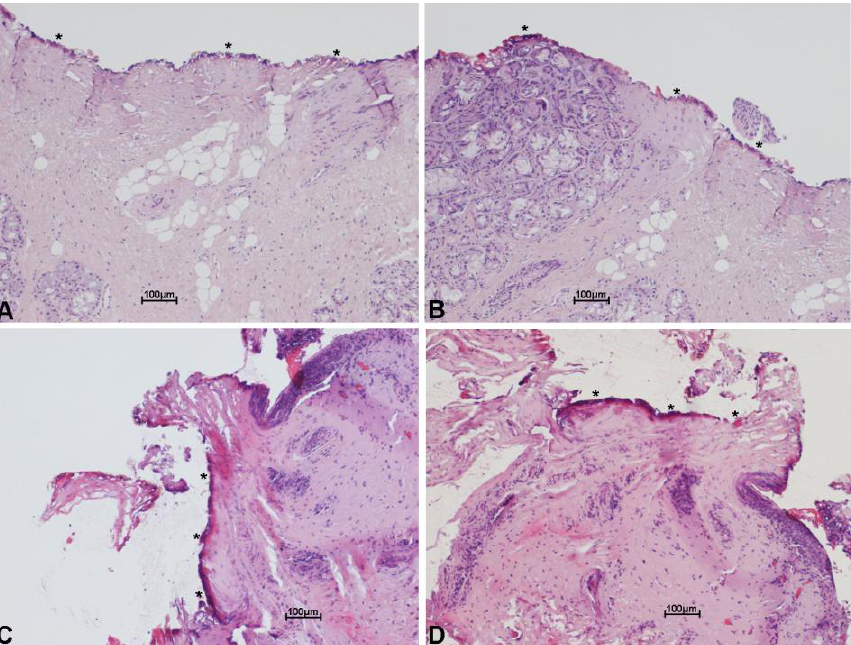
Figure 3. Histological images with hematoxylin and eosin stain, showing minimal thermal effects on the margin of the specimen excised with scanning micromanipulator and superpulsed technology. Thermal damage (*) on the connective tissue ( A – D ) and on the glandular epithelium ( B ), along incision line. Scale bars ×10 ( A – D ).